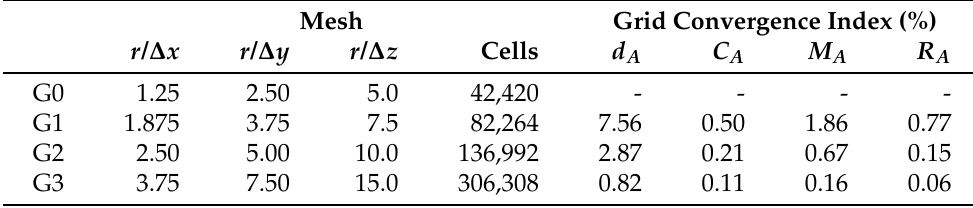
Figure 7. Pressure and velocity in fluid volume of the channel computed using 3D CFD model to obtain fluidic LEM parameters. Table 1. Grid convergence index for the strcutural LEM parameters showing good convergence obtained from the simulations . Here ∆ x , ∆ y , and ∆ z are the grid resolution in x , y , z directions in the central region of the computational domain. The nozzle region has a uniform mesh of resolution ∆ z in all directions. The grid size is normalized with the nozzle radius, r .